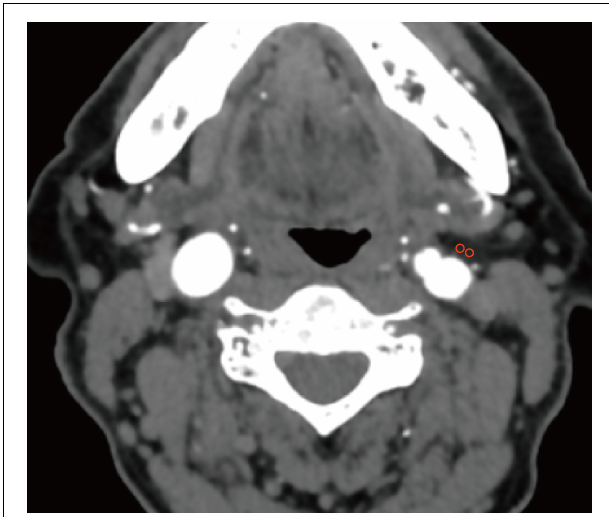
FIGURE 1 | Carotid artery perivascular adipose tissue analysis. Two regions of interest (3 mm 2 in diameter) were placed in the perivascular adipose tissue on the thrombectomy side of the origin of internal carotid artery.